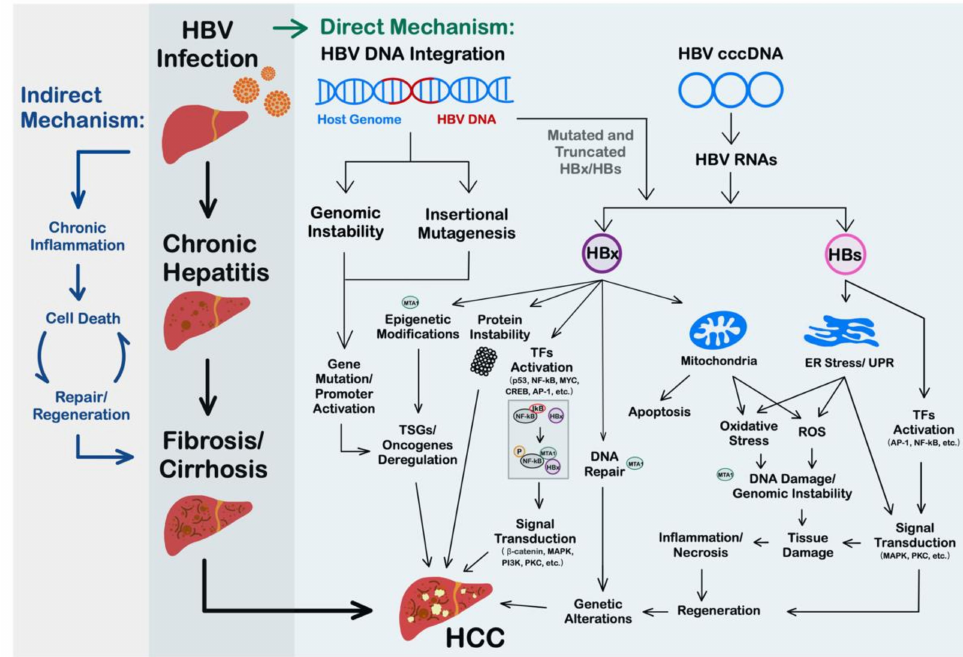
Figure 2. Mechanisms of HBV-related hepatocarcinogenesis. The direct mechanisms of HBV-induced HCC, including HBV DNA integration and persistent expression of viral proteins such as HBx and HBs, can activate cancer-related gene expression and induce genetic instability and oxidative stress. The oncogenic process is promoted by a variety of pathways and mediated by both the host and viral signaling events. In the content of indirect mechanism, the chronic inflammation triggered by host immune responses contribute to ceaseless hepatocyte cell death–regeneration and provides a favorable ground for the emergence of genetic and epigenetic alterations leading to hepatocyte transformation, as well as HCC progression. Furthermore, the potential roles of MTA1 in HBV-related hepatocarcinogenesis are also presented. TSGs, tumor suppressor genes; TFs, transcriptional factors; ER, endoplasmic reticulum; ROS, reactive oxygen